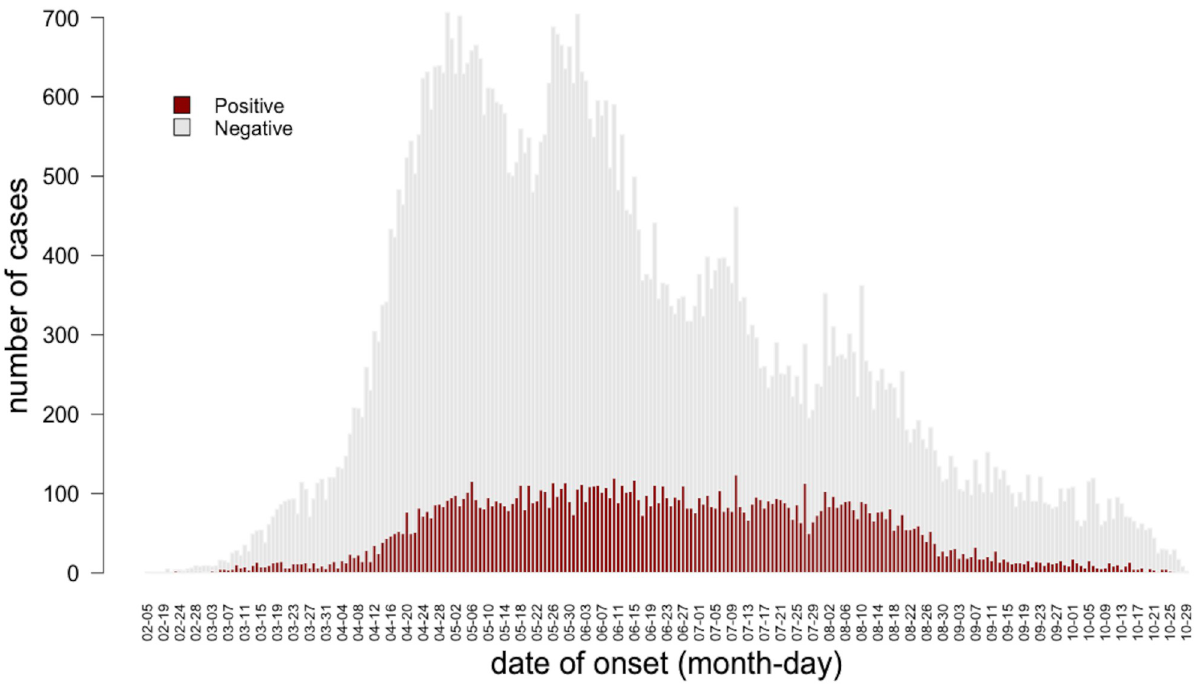
Fig 1. Epidemic curve. Dates of onset are represented in the x-axis and number of cases on the y-axis. The top of the vertical bars indicates the total number of new suspected cases per day. Grey part of the bars represents negative cases while red part positive cases.